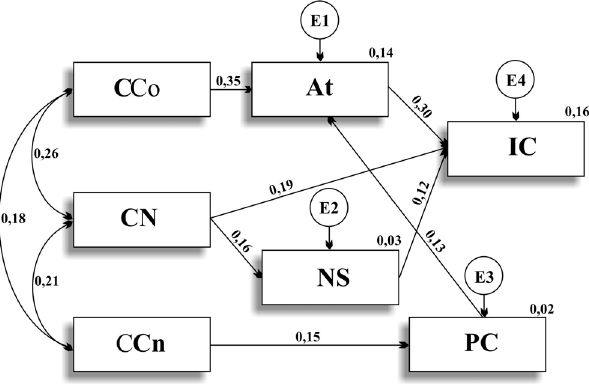
Figura 3. Modelo das relações entre a Atitude (At), Crença Comportamental (CCo), Norma Subjetiva (NS), Crença Normativa (CN), Percepção de Controle (PC), Crença de Con- trole (CCn) e a Intenção Comportamental (IC) para os beneficiários do Grupo A Nota. [ χ 2 /gl = 1,29; GFI = 0,98; RMR = 0,05; RMSEA = 0,03 ( IC = 0,00 e 0,08); CFI = 90